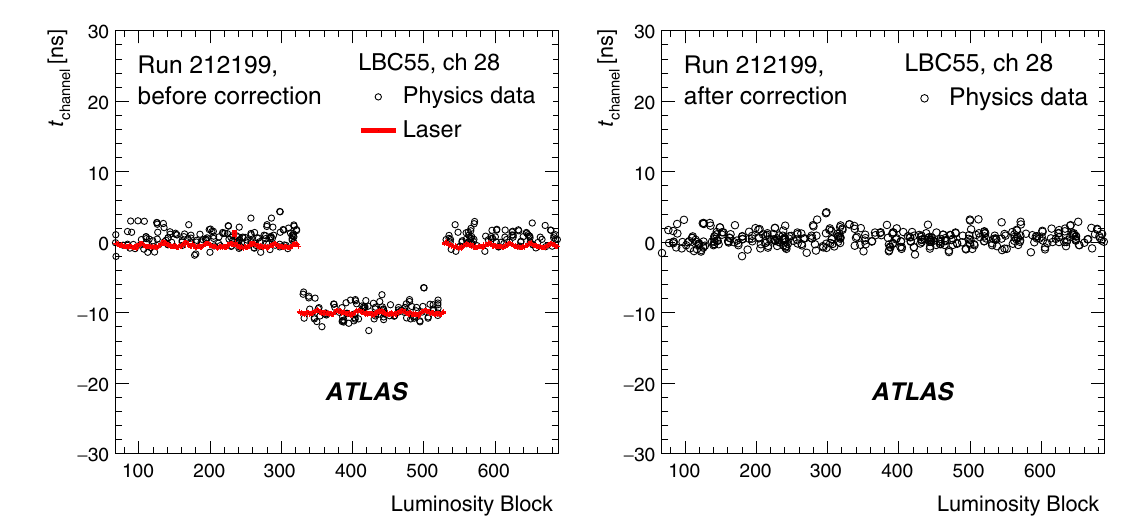
caused by the energy dependence of the reconstructed time in jet events (see Fig. 5, left). In these plots, events with any energy are accepted to